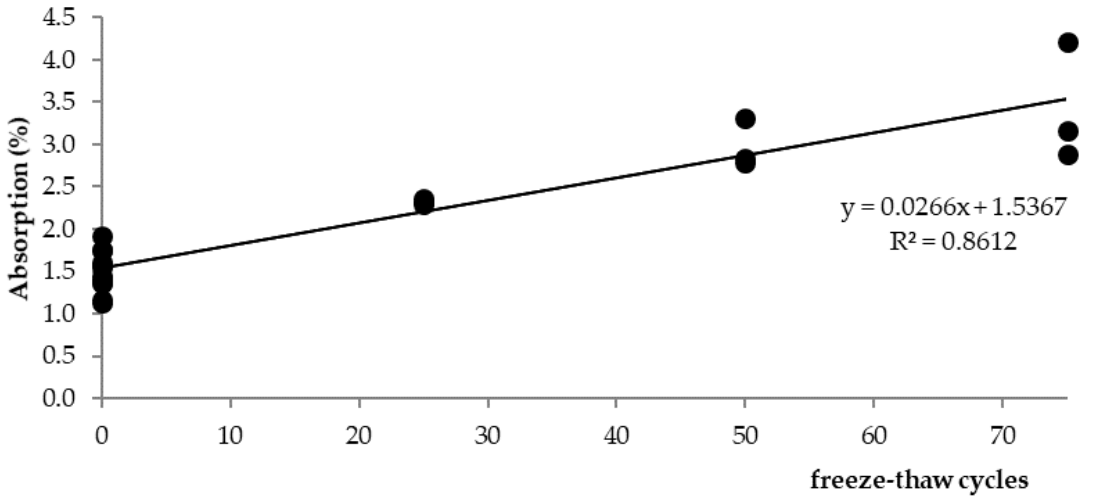
Figure 8. Absorption (%) of the ACO 11 + mixture depending on the number of freeze–thaw cycles.